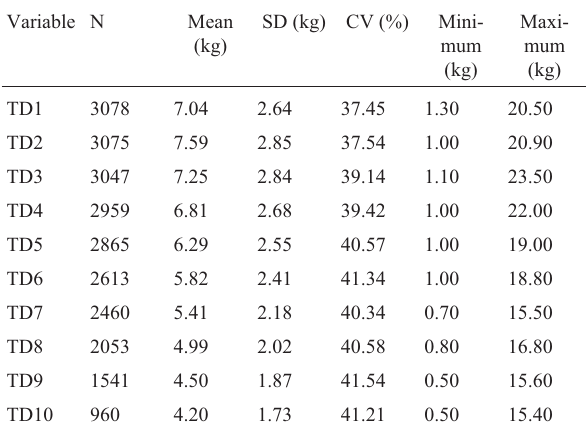
Table 1 - Number of observations (N) and mean, standard deviation (SD), coefficient of variation (CV) and minimum and maximum values of test-day milk yield in kg (TD1 to